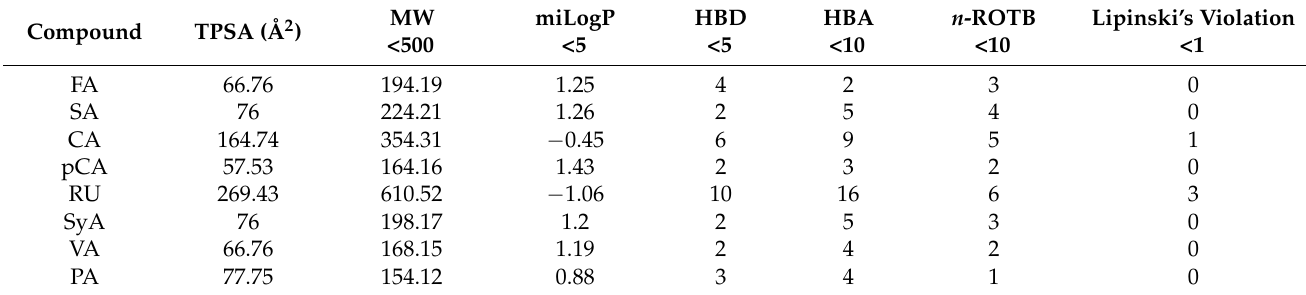
Table 3. Drug-like properties of isolated compounds.